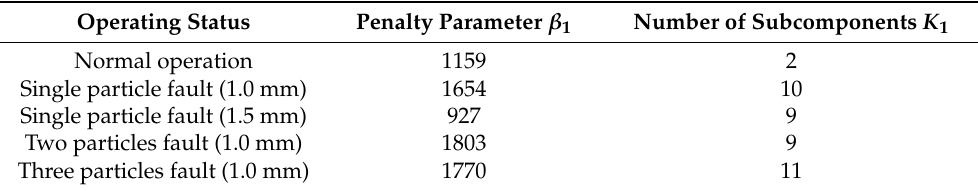
Table 3. Best parameter combination of vibration